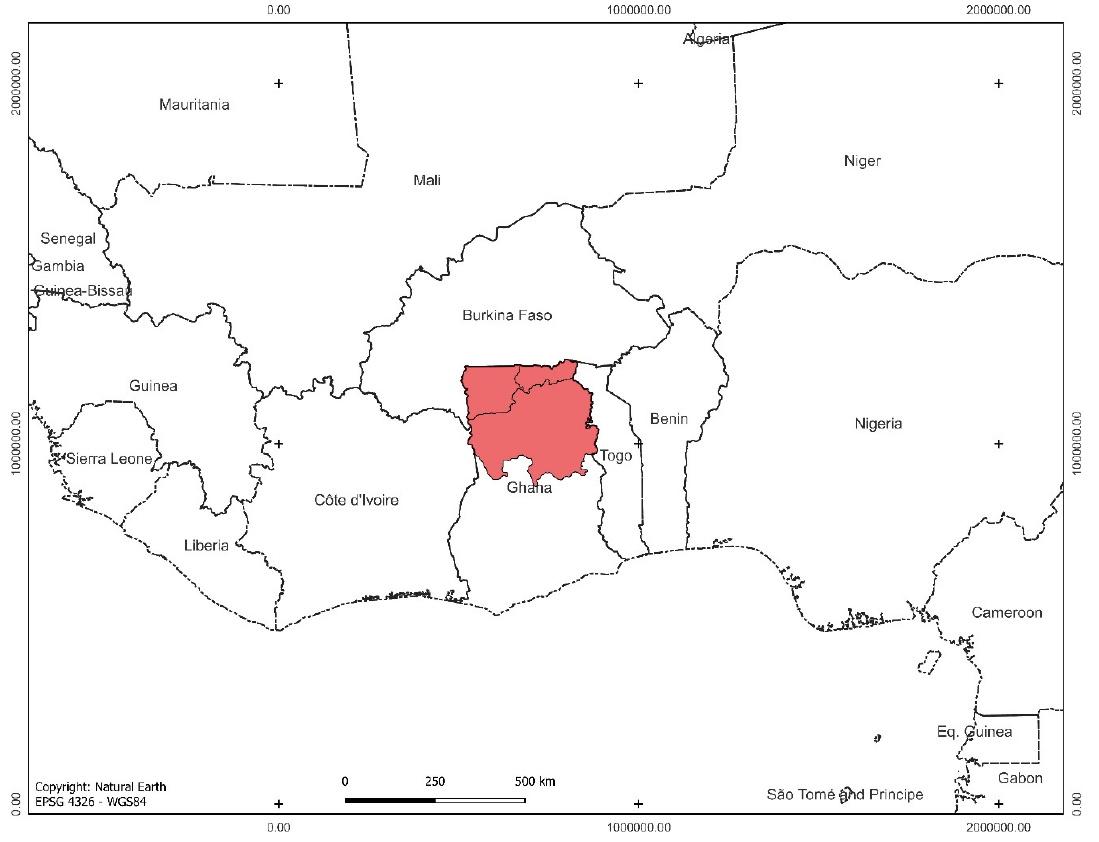
Figure 1. Location of the study area comprising Northern, Upper West, and Upper East provinces